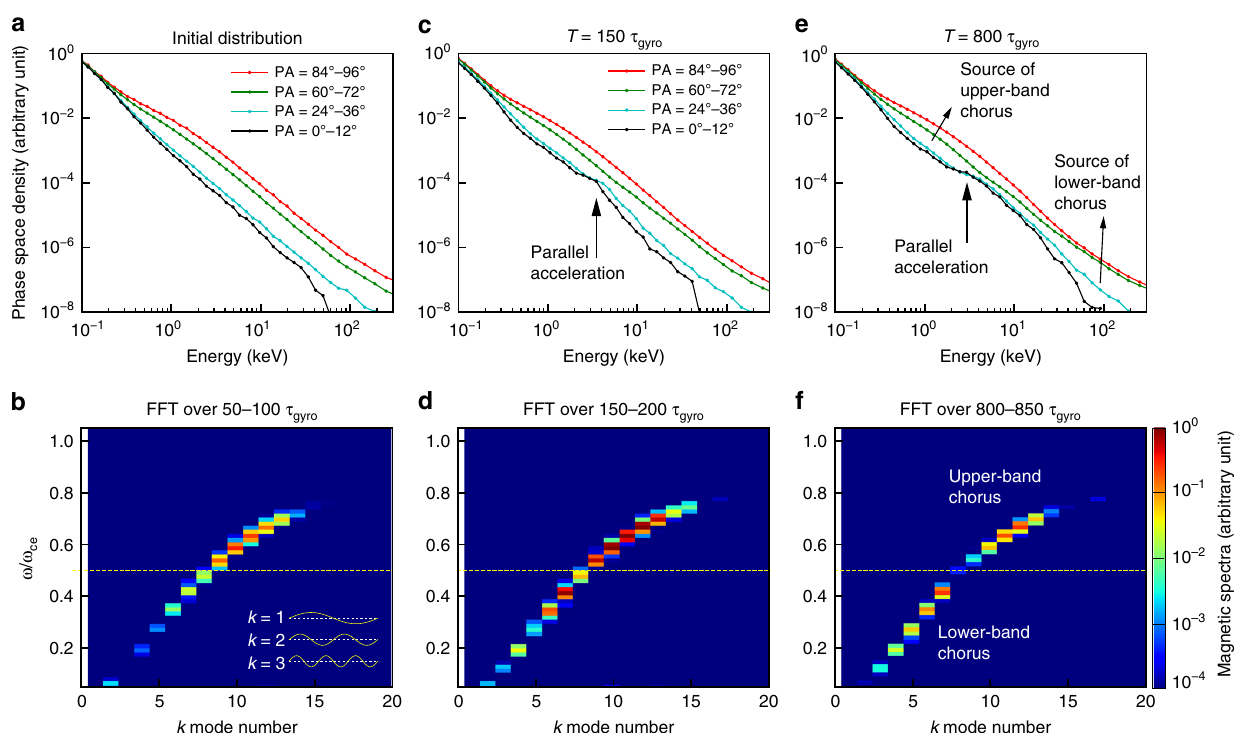
Fig. 4 Simulation of chorus wave excitation and the concurrent electron PSD variation. a The initial electron PSD versus energy at selected pitch angles, showing a cold isotropic population extending to ~100 eV and a warm anisotropic population above ~ 300 eV. b The wave magnetic spectral intensity for each ( ω , k ) mode obtained by Fourier transformation of the magnetic fi eld over T = 50 – 100 τ gyro (electron gyro-period), showing a continuous one-band spectral structure, while the excitation of upper-band chorus is faster. c The electron PSD at T = 150 τ gyro , showing a notable parallel acceleration at ~2 – 3 keV, which is around the Landau resonant energies of the chorus waves. d As the chorus waves at both bands continues to grow, the wave intensity at 0.5 f – 3 keV. e At T = 800 τ ce is notably weaker than the two bands, due to the reduce anisotropy at ~2 gyro , the electron PSD exhibits two distinct anisotropic components, separated by the electrons that have undergone parallel acceleration by chorus waves. f The resultant two-band chorus waves with a gap at 0.5 f ce . The upper-band chorus grows from the ~1 keV anisotropic component, and the lower-band chorus grows from tens of keV anisotropic